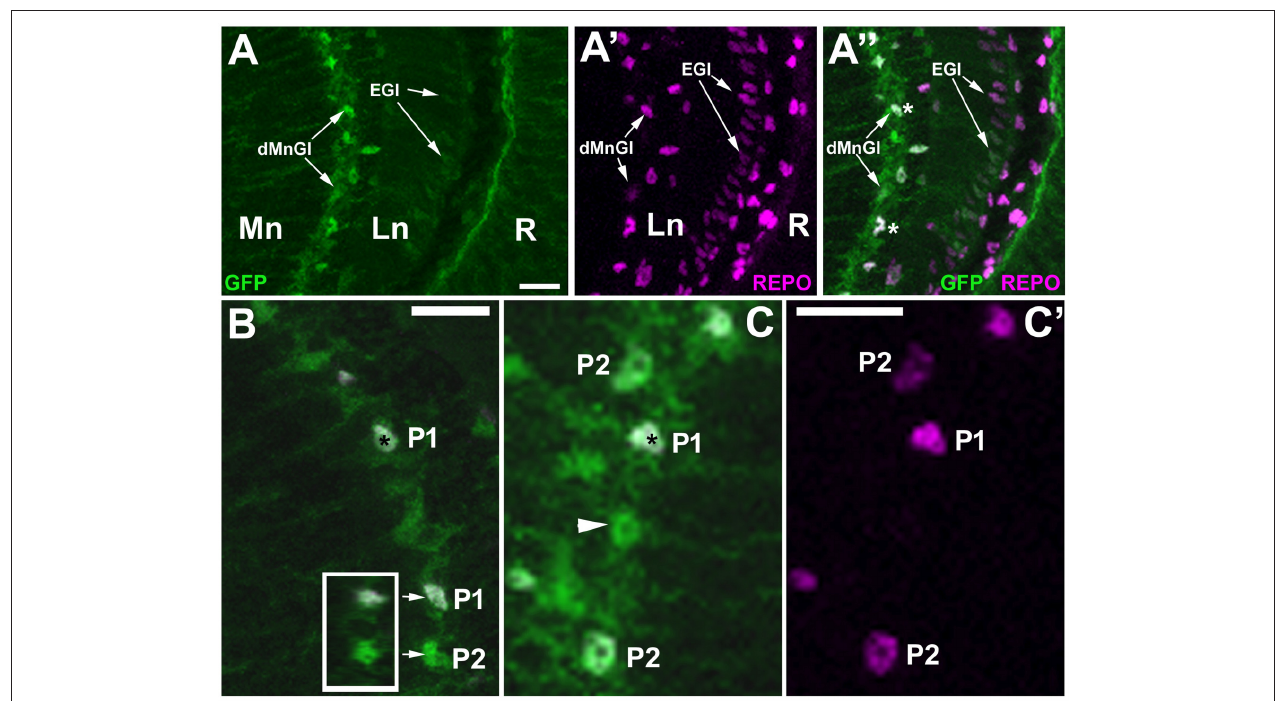
FIGURE 7 | Anti-REPO immunolabeling of GFP-labeled tim -expressing cells in the visual system of tim -Gal4/UAS-S65T-GFP flies collected at ZT1. (A–A”) The strong fluorescence of GFP-reporter is observed in the dMnGl, whereas the weak fluorescence is visible in the other glial cells, e.g., the epithelial glial cells (EGl) of the lamina neuropil (Ln). R, retina; Mn, medulla neuropil. (B) Exemplary GFP-positive cells revealing higher (P1) and lower (P2) levels of REPO-specific fluorescence. Insert: the orthogonal view ( z -stack projection) of P1 and P2 (arrows) showing that their nuclei are complete (so the difference in the intensity of REPO-specific immunofluorescence results entirely from the differences in the level of REPO expression). (C,C’) TIM-positive cells (green) in the distal medulla show either high (P1), low (P2), or no expression of REPO (arrowhead). The nuclei of cells revealing high level of expression of GFP and REPO are marked with asterisks. Scale bars in all panels: 10 µ